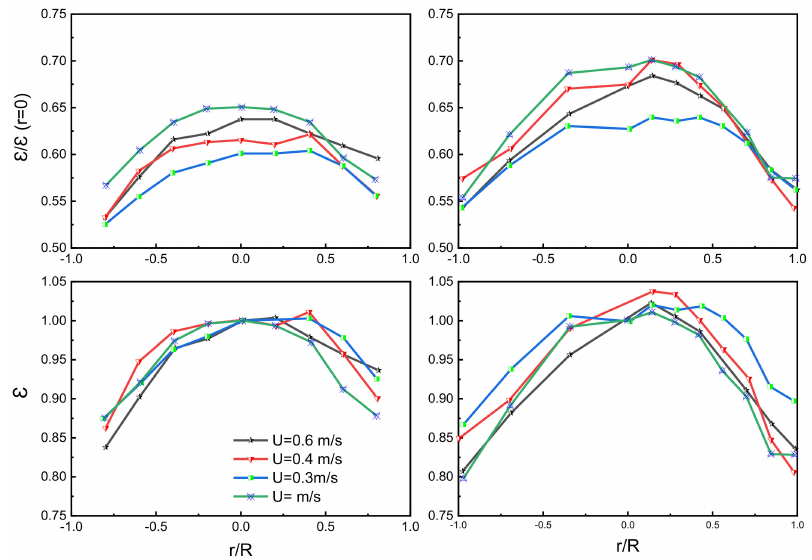
Figure 9. Effect of distributor type on lateral voidage profiles. Adopted from Sobrino et al.